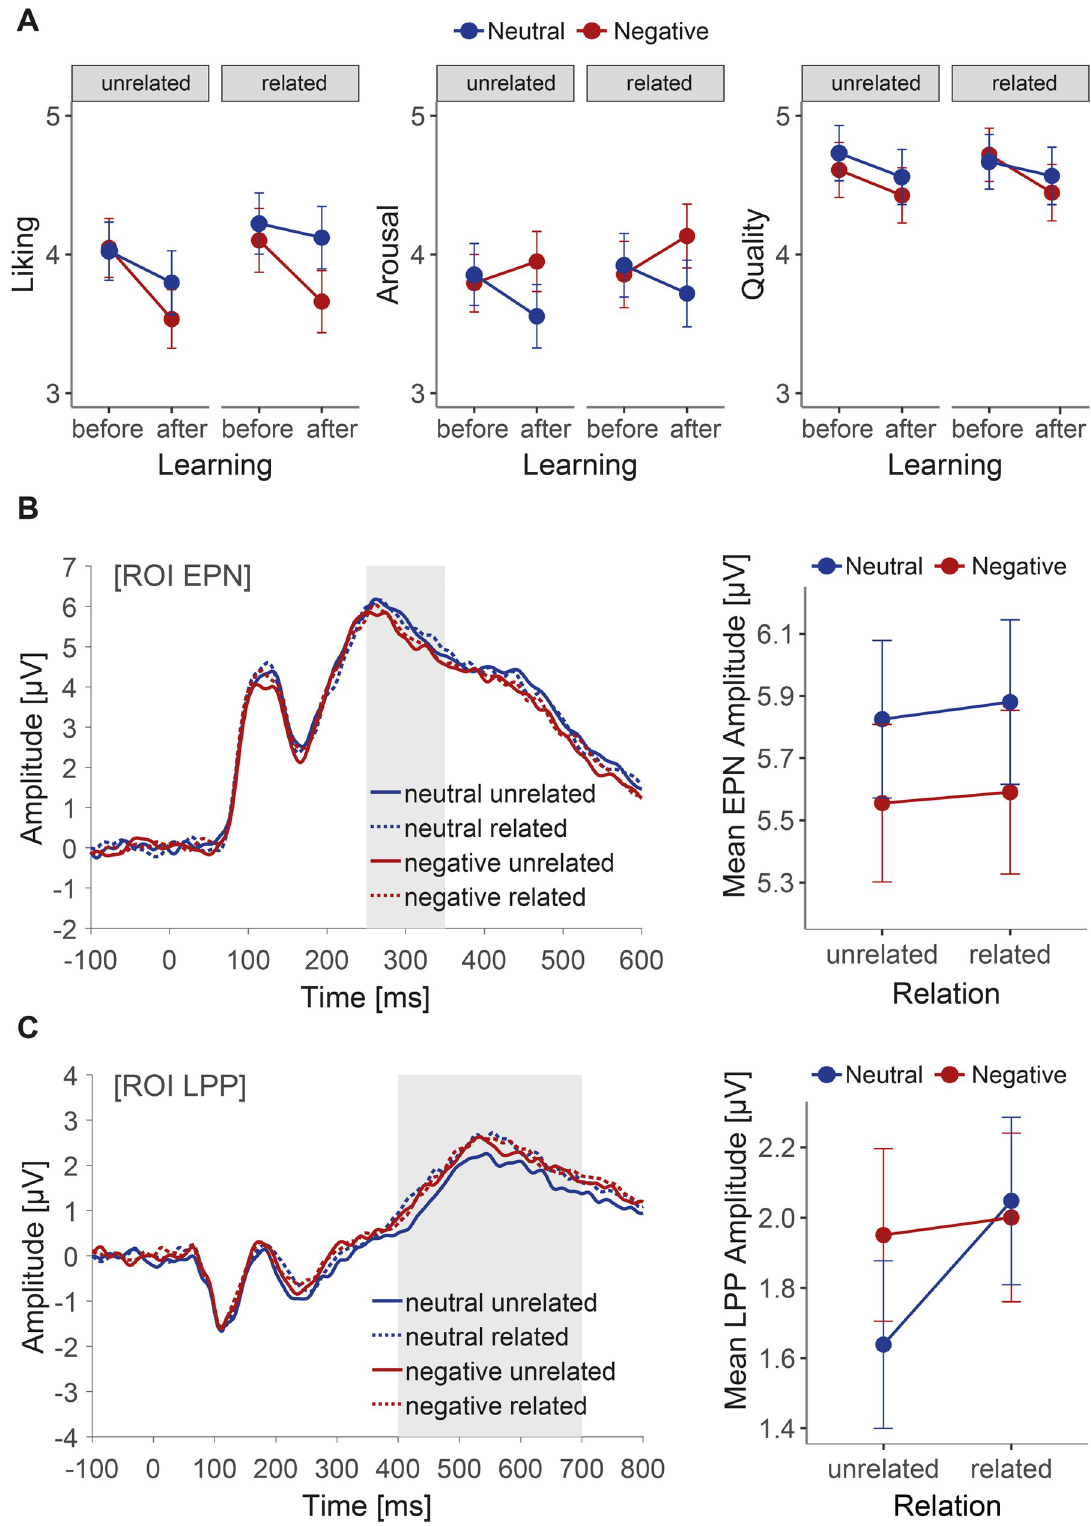
Fig 3. Effects of biographical knowledge and relatedness between knowledge and contents of paintings on reception of artworks. (A) Ratings of liking, arousal and quality before and after the acquisition of knowledge. Range of scales was 1 to 7. Higher